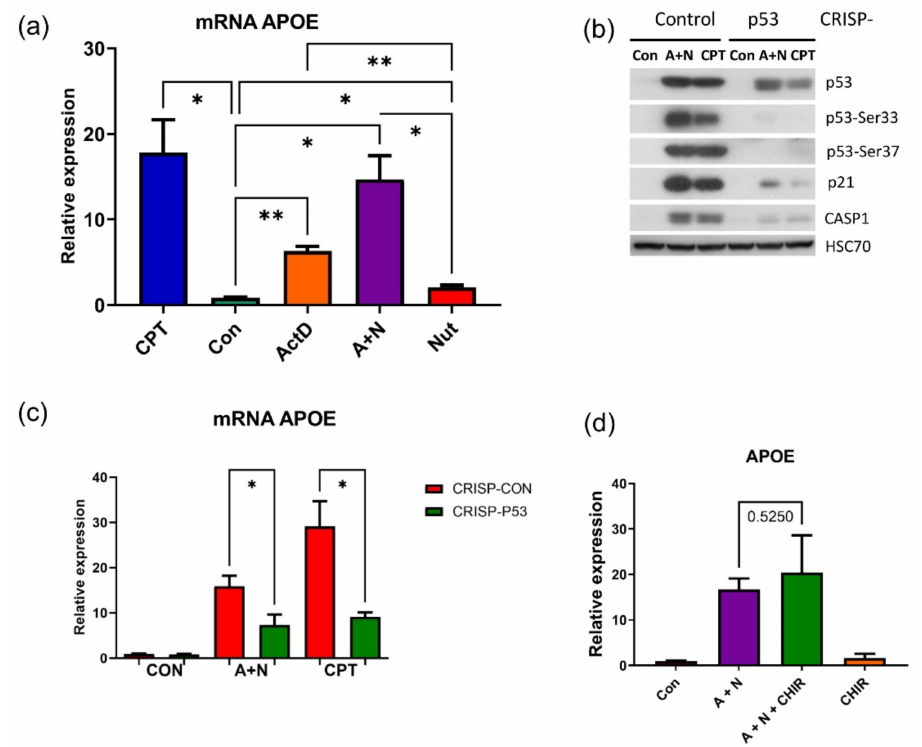
Figure 3. APOE is regulated in p53-dependent fashion. ( a ) Measurement of relative APOE mRNA level in A549 cells exposed to indicated substances or their combinations for 30 h. CPT-camptothecin, ActD-actinomycin D, Nut-nutlin-3a. The mean and standard deviation from three biological replicates performed in triplicate are presented, p values calculated by Brown-Forsythe and Welch’s ANOVA tests (* p < 0.05, ** p < 0.01) ( b ) Expression of indicated proteins (or p53 phosphorylated on Ser33, Ser37) in p53 knockdown (CRISP) A549 cells or in controls for knockdown. Cells were exposed to A + N or CPT for 30h. ( c ) Relative APOE mRNA levels in p53 knockdown cells (CRISP-p53) or the control cells for knockdown (CRISP-Con) exposed to A + N or CPT for 30 h. The results represent mean and standard deviation from three independent experiments in triplicate, p values calculated by Brown-Forsythe and Welch’s ANOVA tests (* p < 0.05). ( d ) The level of APOE mRNAs measured by semi-quantitative real-time PCR of samples isolated from mock-treated A549 cells (Con) or from cells incubated for 30 h as indicated. The mRNA level in the control cells was defined as 1 (means and standard deviations from three biological replicates). The concentration of CHIR-98014 was 1 µ M. Statistical differences in expression were as calculated using unpaired t test with Welch’s correction ( p =